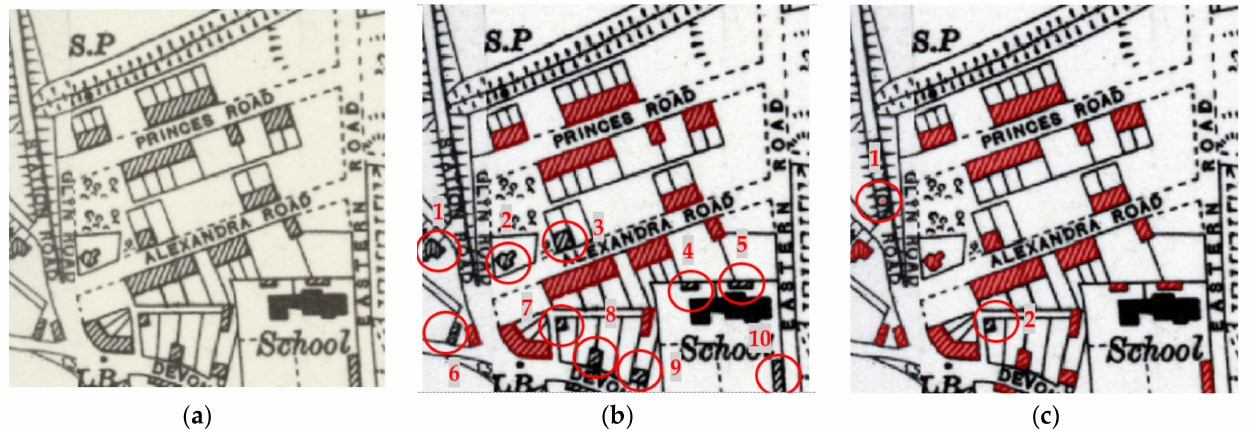
Figure 9. Segmentation results of the Gabor filter-based algorithm and the AEHRA-based method. ( a ) Original raster image; ( b ) results of Gabor filter-based method; ( c ) results of AEHRA-based